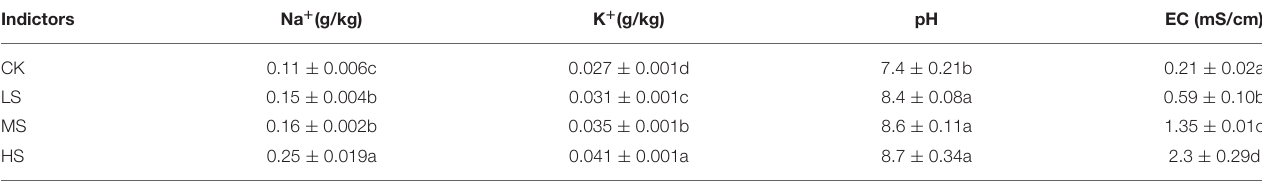
TABLE 1 | The physical and chemical properties of soils. Indictors Na + (g/kg) K +